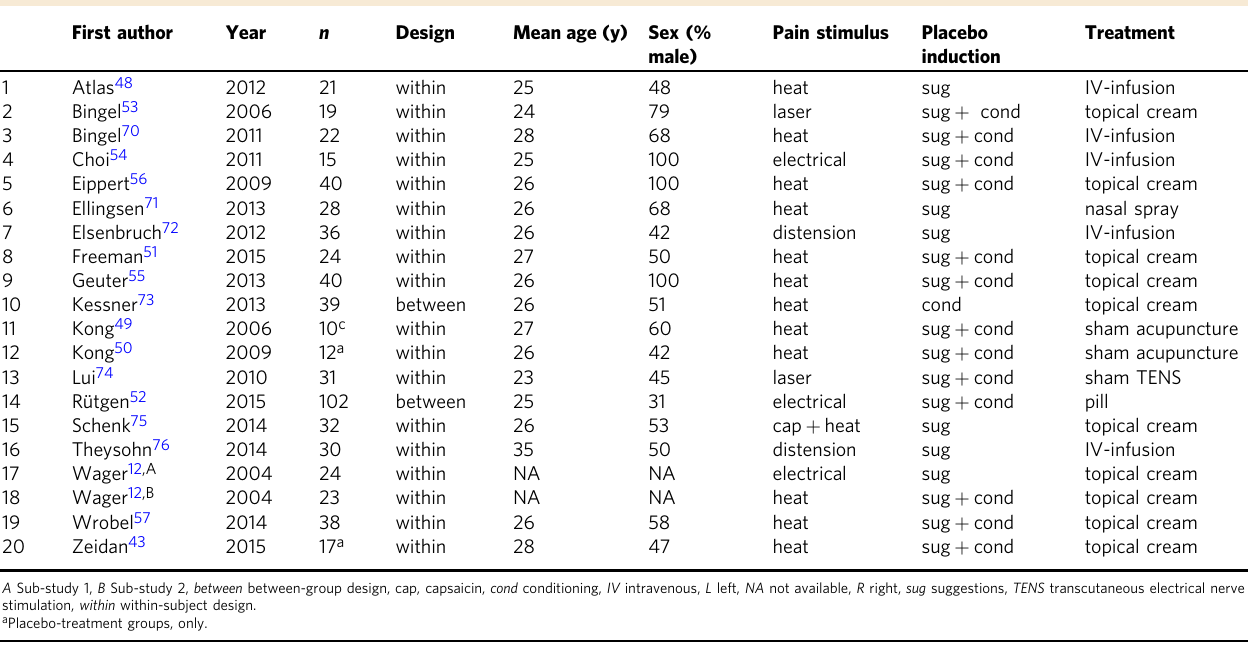
Table 1 Studies included in the meta-analysis.